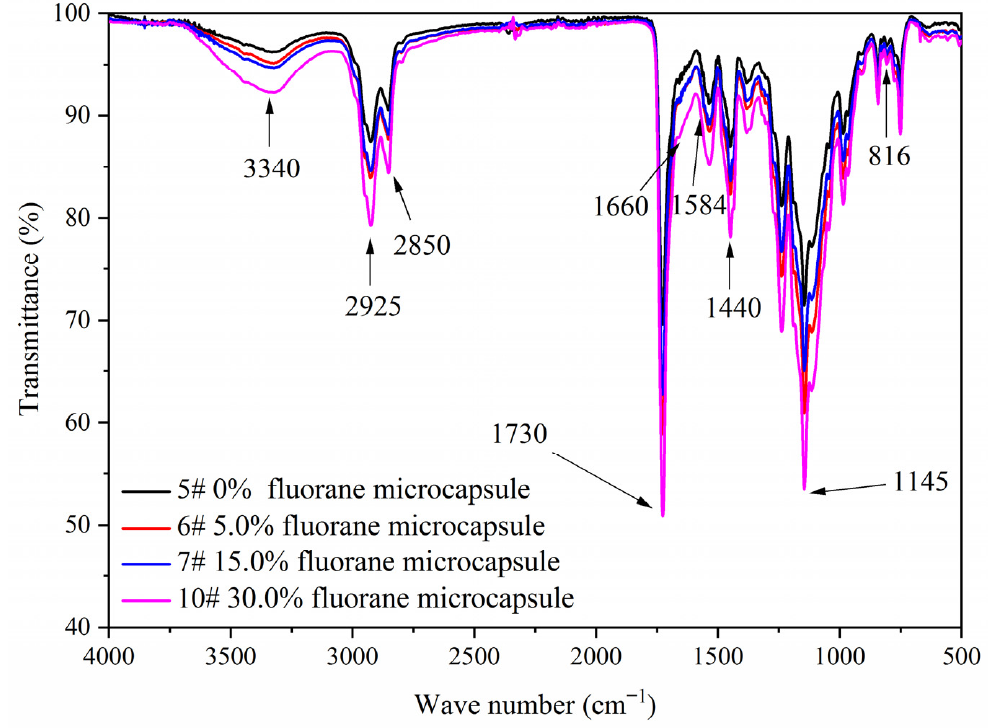
Figure 7. FTIR of the coating film with different fluorane microcapsule